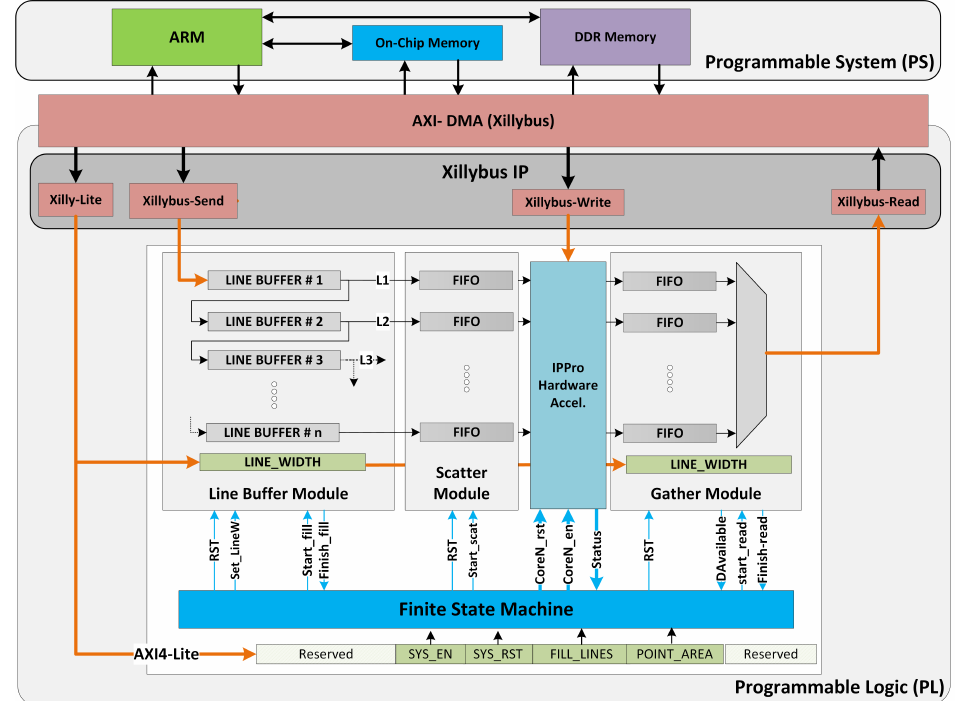
Figure 9. System architecture of IPPro-based hardware acceleration highlighting data distribution and control infrastructure, FIFO configuration and Finite-State-Machine